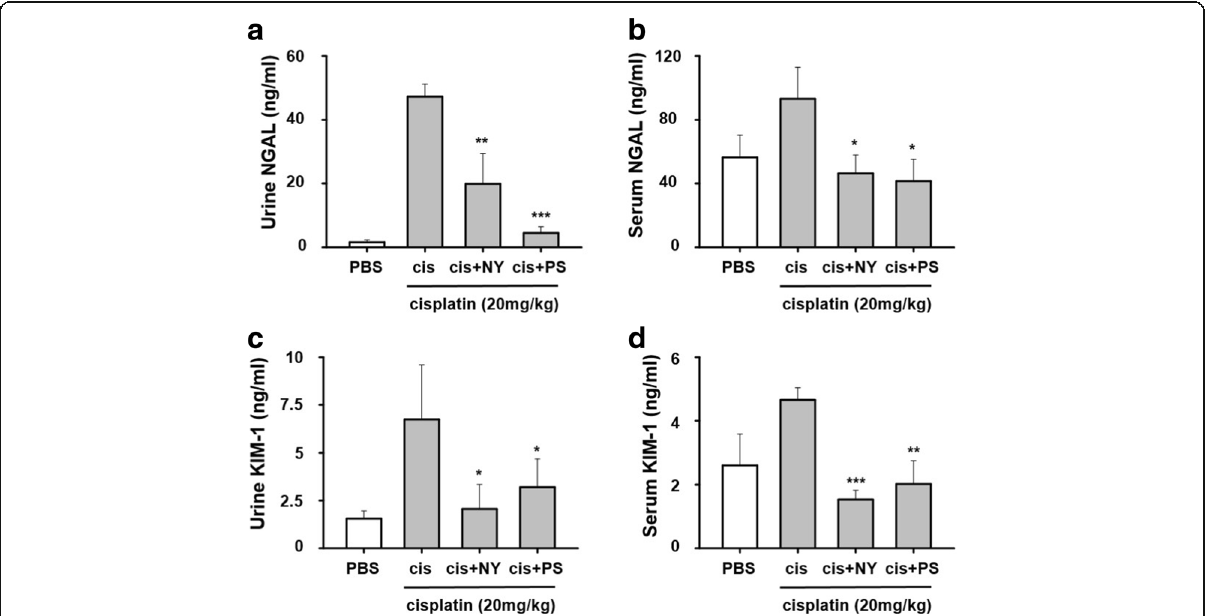
Fig. 6 Herbal medicines ameliorated cisplatin-induced kidney injury markers. Mice were given an intraperitoneal injection (i.p.) of cisplatin (20 mg/kg) for 3 days. After Nelumbo nymphaea (NY) , Paeonia suffruticosa (PS) given an orally administration (300 mg/kg) for 3 days. Concentration of NGAL and KIM-1 were measured in urine and serum ( a – d ). All the values are expressed as mean±S.E.M., n =3 in each group. *, ** and *** statistically different from cisplatin at p <0.05, p <0.01 and p <0.001, respectively